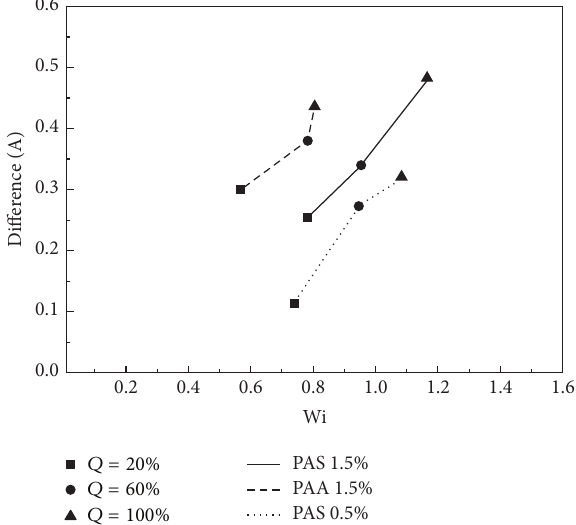
Figure 30: The PAS Weissenberg number: difference diagram of various flows in 180 ∘ curved